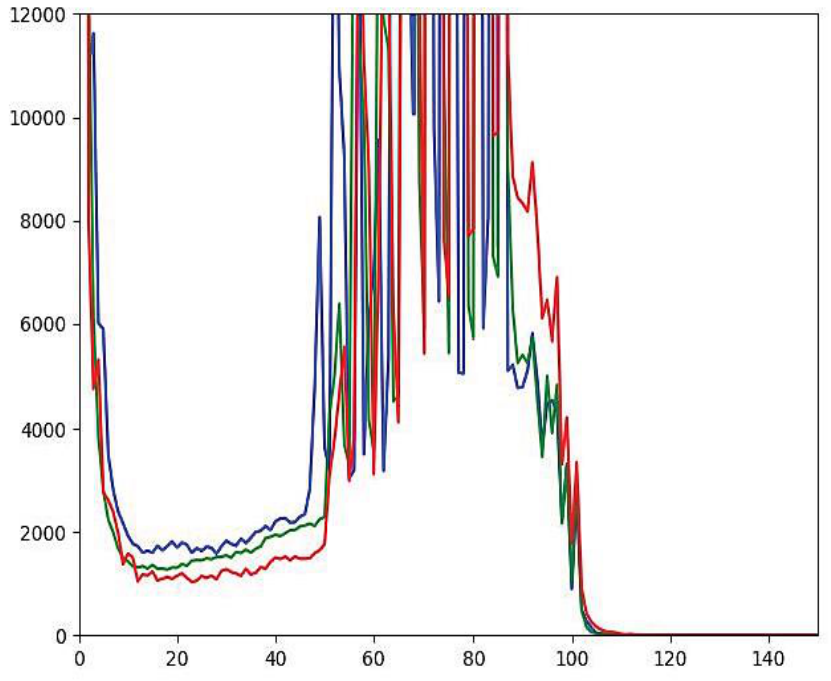
Figure 43. Histogram of RGB graph for the image (see Figure